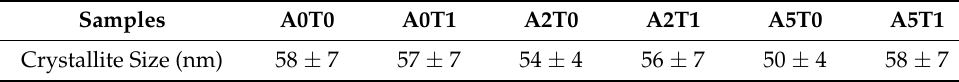
Table 1. Crystallite size of the cements.